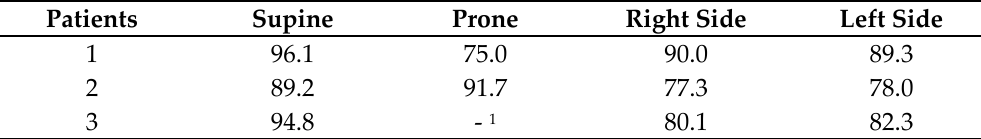
Table 1. BCG measurement validation with assistance of the ECG